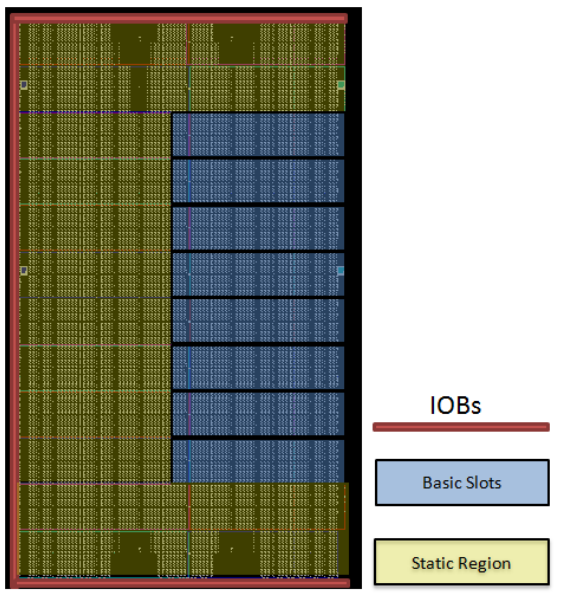
Figure 5. Resource utilization of the